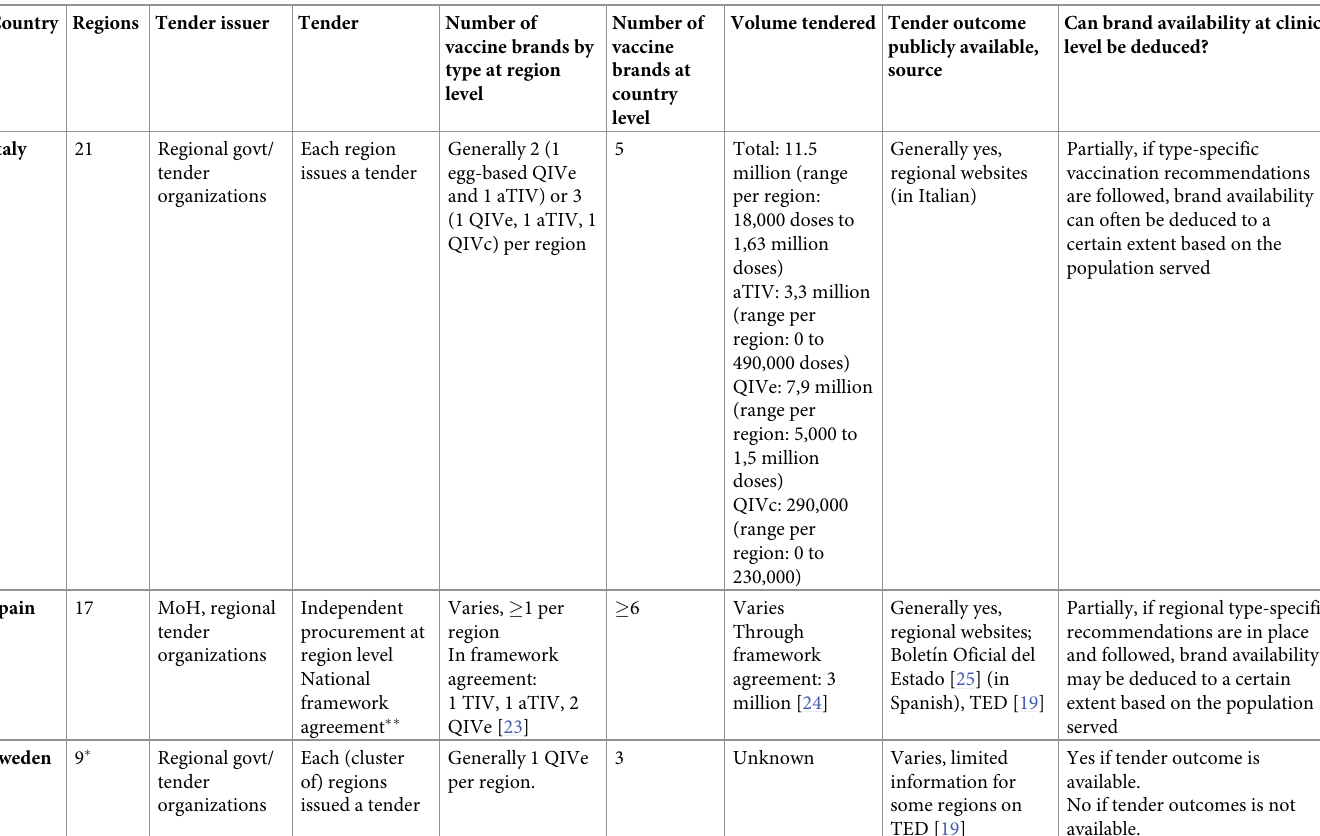
Table 2. Trends in vaccine types and number of brands procured through regional public tenders (2019–2020 season). Country Regions Tender issuer